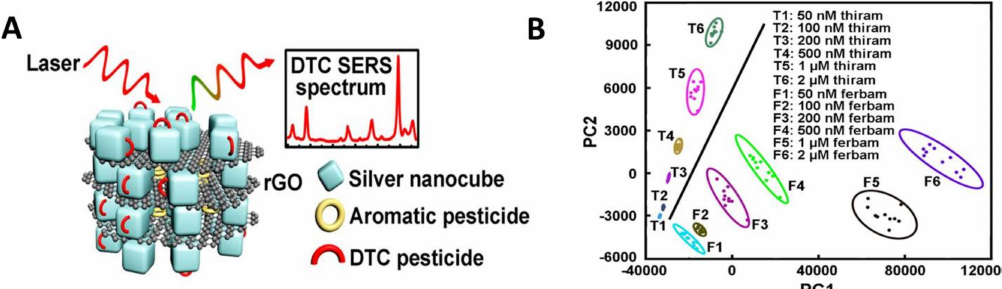
Figure 3. ( A ) Principle of the surface enhanced Raman scattering (SERS) detection of DTF using rGO-wrapped Ag nanocubes. ( B ) Principal component analysis (PCA) plot (PC1 versus PC2) of signals extracted from 10 SERS spectra of thiram and ferbam with concentration ranging from 50 nM to 2 µ M. Reproduced from [21] with